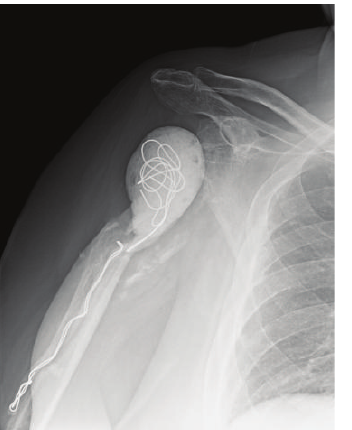
Figure 6: Radiograph at one year after the final I and D showing the cement spacer that the patient was asked to “live with.”